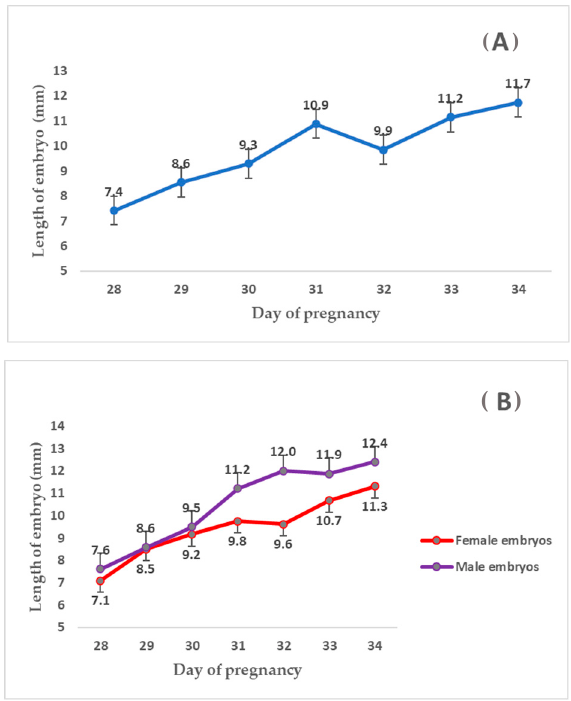
Figure 2. Mean lengths (±S.D.) for the total sample of co-twins. ( A ) n = 184 for male and female embryos. ( B ) n = 90 from day 28 to 34 of pregnancy.